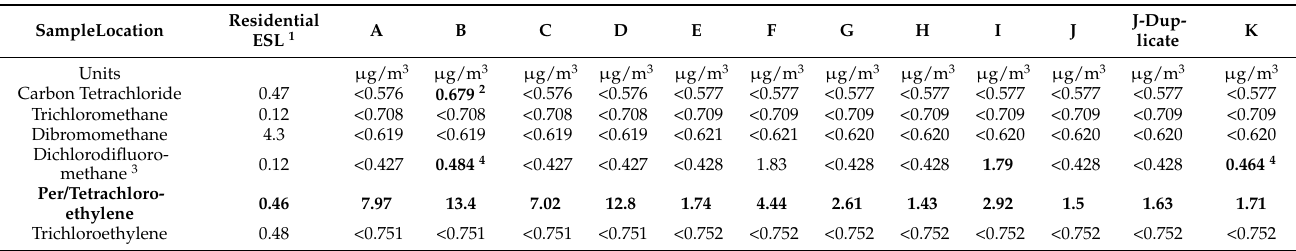
Table 4. 12 Indoor-Air, Lower or Uncalibrated Passive-Sorbent-Sampler Results: 6 Toxic Chemicals at 11 Locations, Former Naval Ordnance Testing Station, Pasadena, California, NOTSPA (Authors’ Chapter 4 in the online Supplemental Materials). Bold = Violations of the